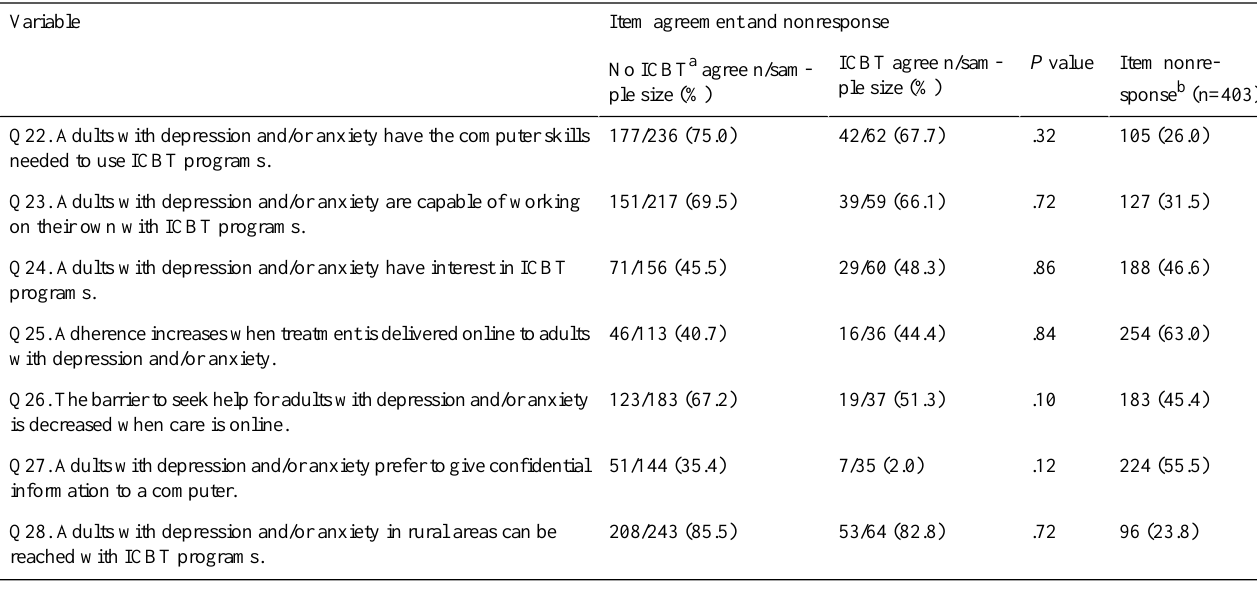
Table 2. Implementers and nonimplementers agreeing to user-related items.